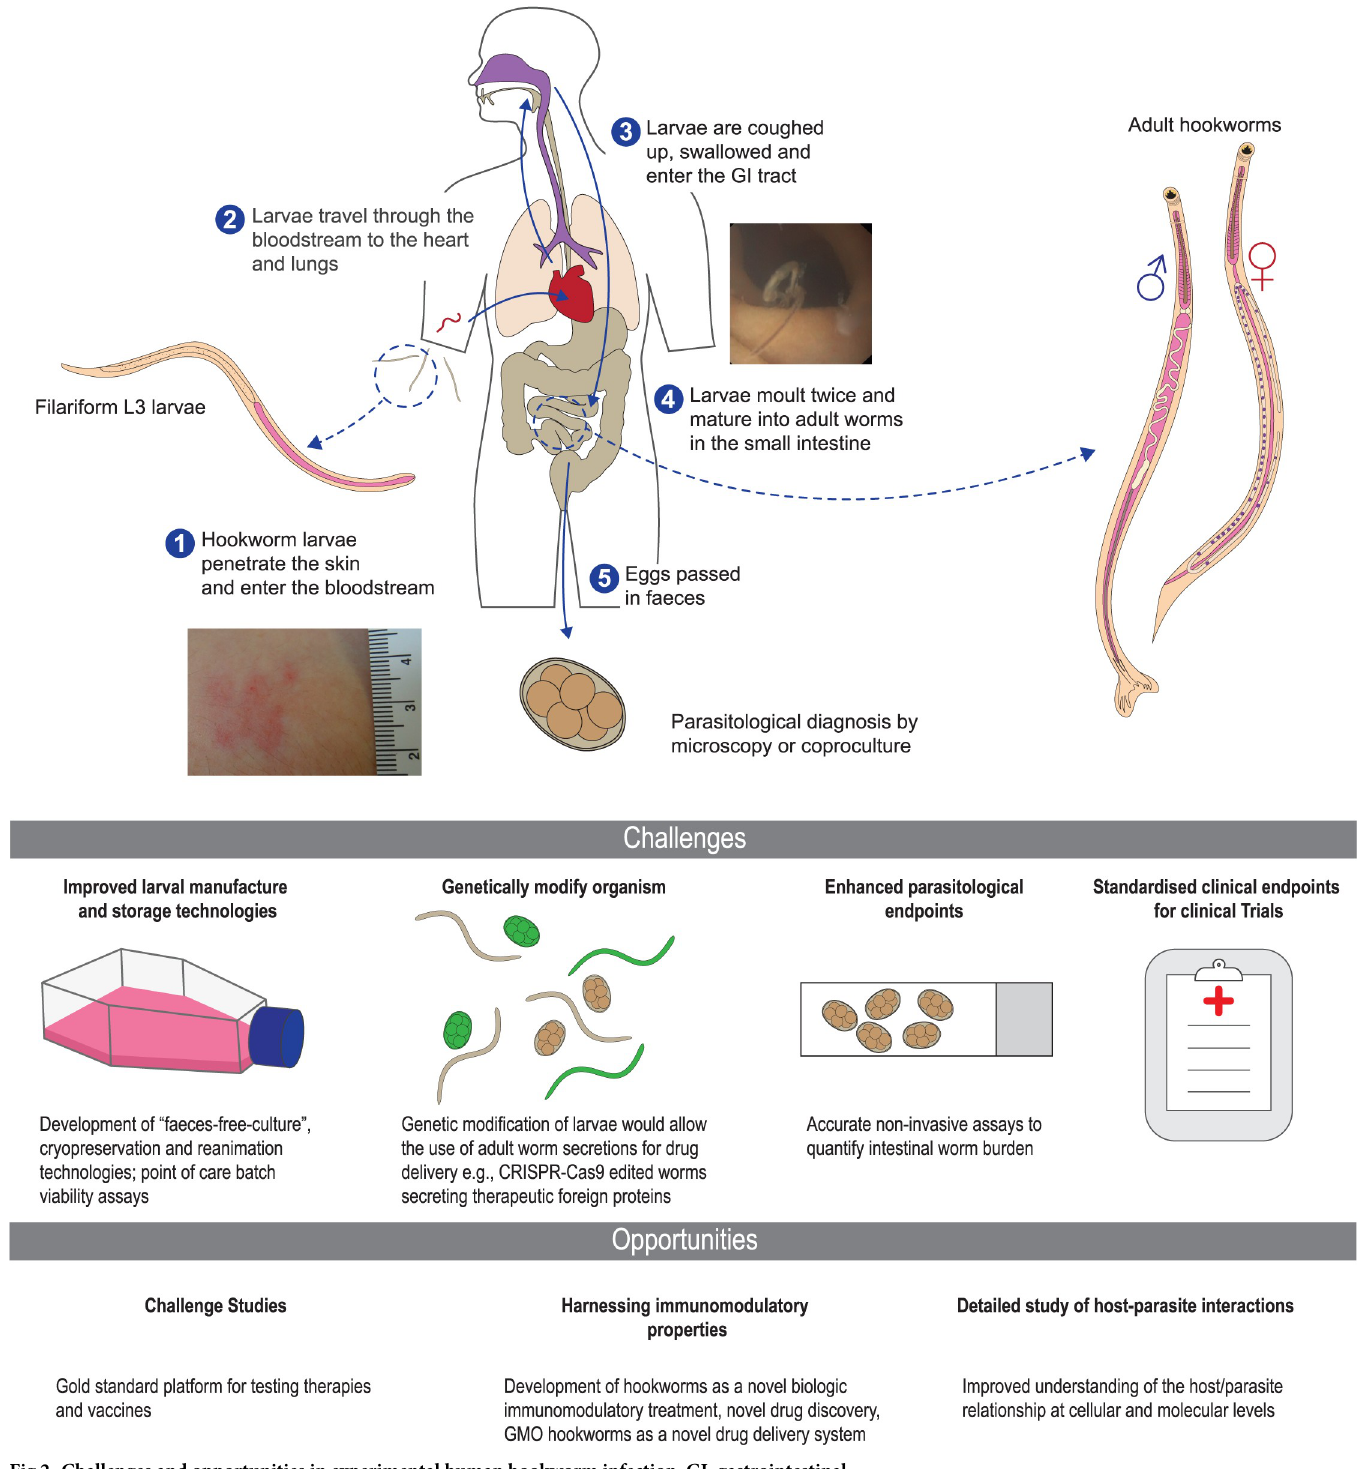
Fig 2. Challenges and opportunities in experimental human hookworm infection. GI, gastrointestinal.